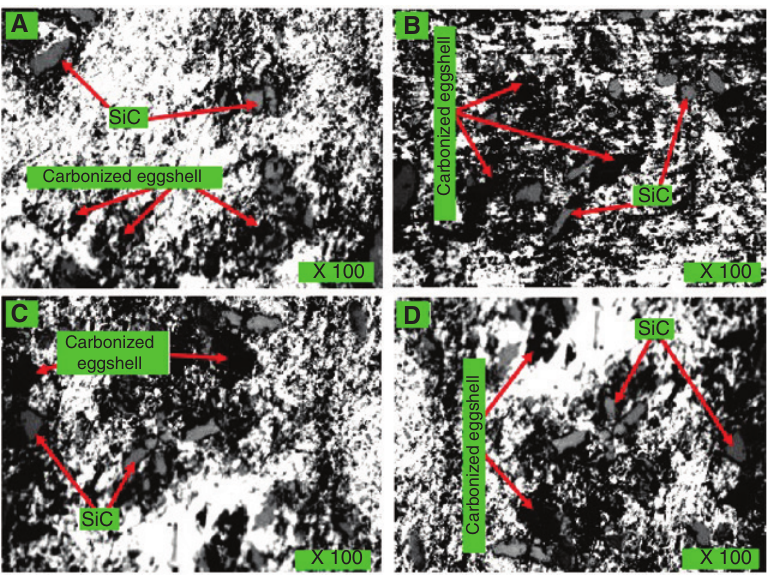
Figure 7: Microstructure of AA2014 reinforced ( × 100) with (A) 2.5% SiC + 2.5% eggshell, (B) 2.5% SiC + 7.5% eggshell, (C) 2.5% SiC + 12.5% eggshell, and (D) 12.5% SiC + 2.5%